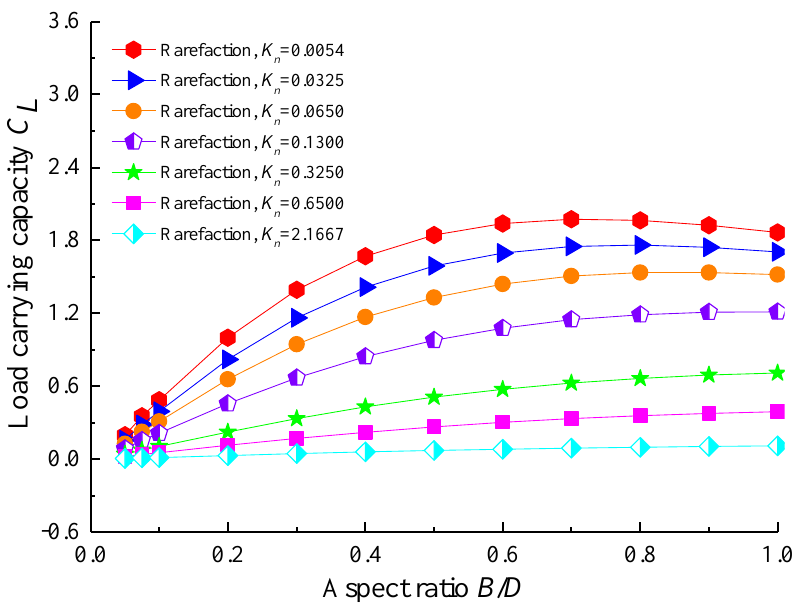
Figure 7. Non-dimensional load carrying capacity of Boltzmann model vs. aspect ratio for different Knudsen numbers ( Λ = 5, ε = 0.6).